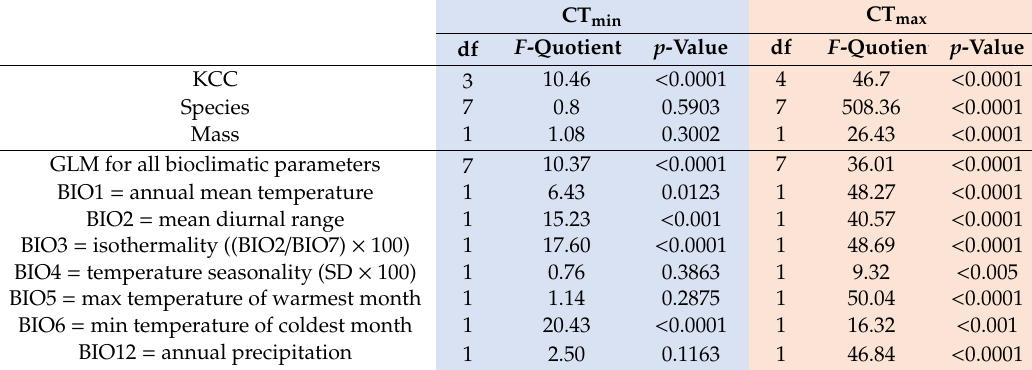
Table 3. Statistical analysis of CT min and CT max on Köppen–Geiger climate classification (KCC), species, body mass, (via multifactorial ANOVA), and bioclimatic parameters (via general linear model (GLM)).